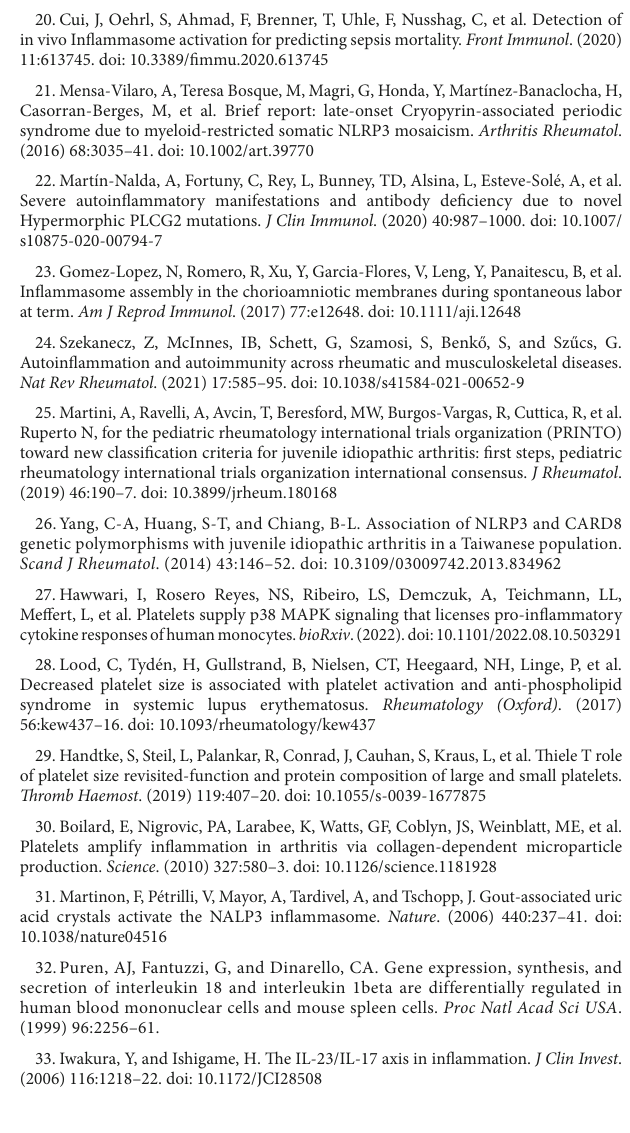
SUPPLEMENTARY FIGURE S2 Correlation of IL-1 β and IL-18 in serum from JIA patients. Spearman r correlation, a p-value * p < 0.05 was considered